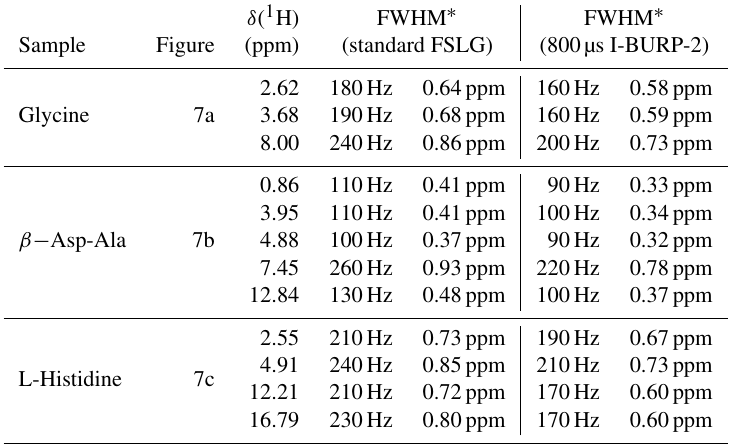
Table 1. Full width at half maximum (FWHM) for homonuclear decoupled proton spectra at 500MHz shown in Fig. 7. δ ( 1 H) FWHM ∗ FWHM ∗ Sample Figure (ppm) (standard FSLG) (800µs